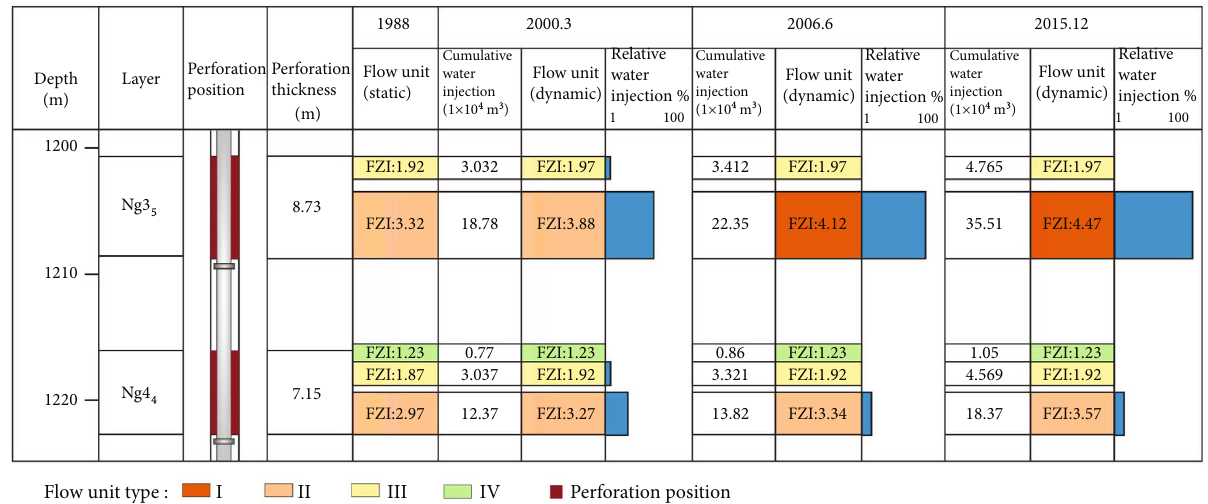
Figure 13: Test results of increasing interlayer di ff erential water absorption pro fi le.